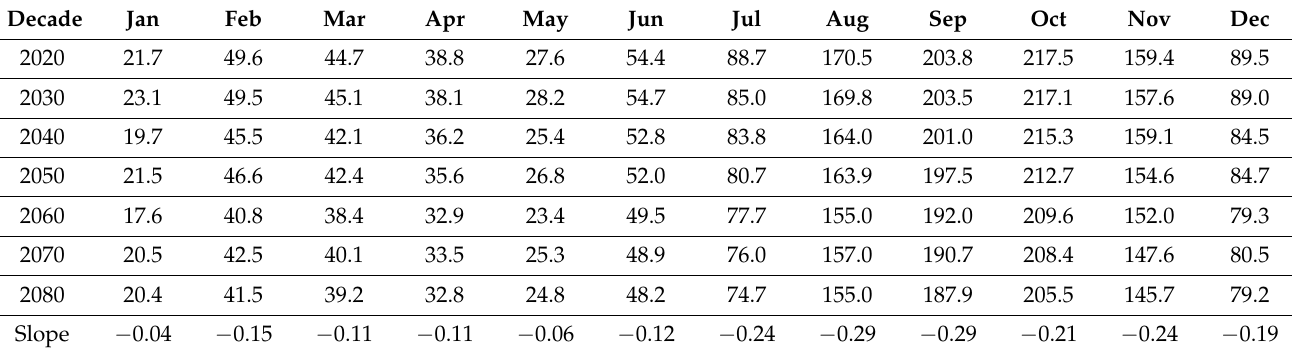
Table 4. Monthly mean precipitation values per decade and their trend for Curarrehue, Chile, obtained from the application of the delta method to the coupled models (CMIP5) and for the average of the four routes of the Representative Concentration Trajectories (RCP) found in the latest IPCC